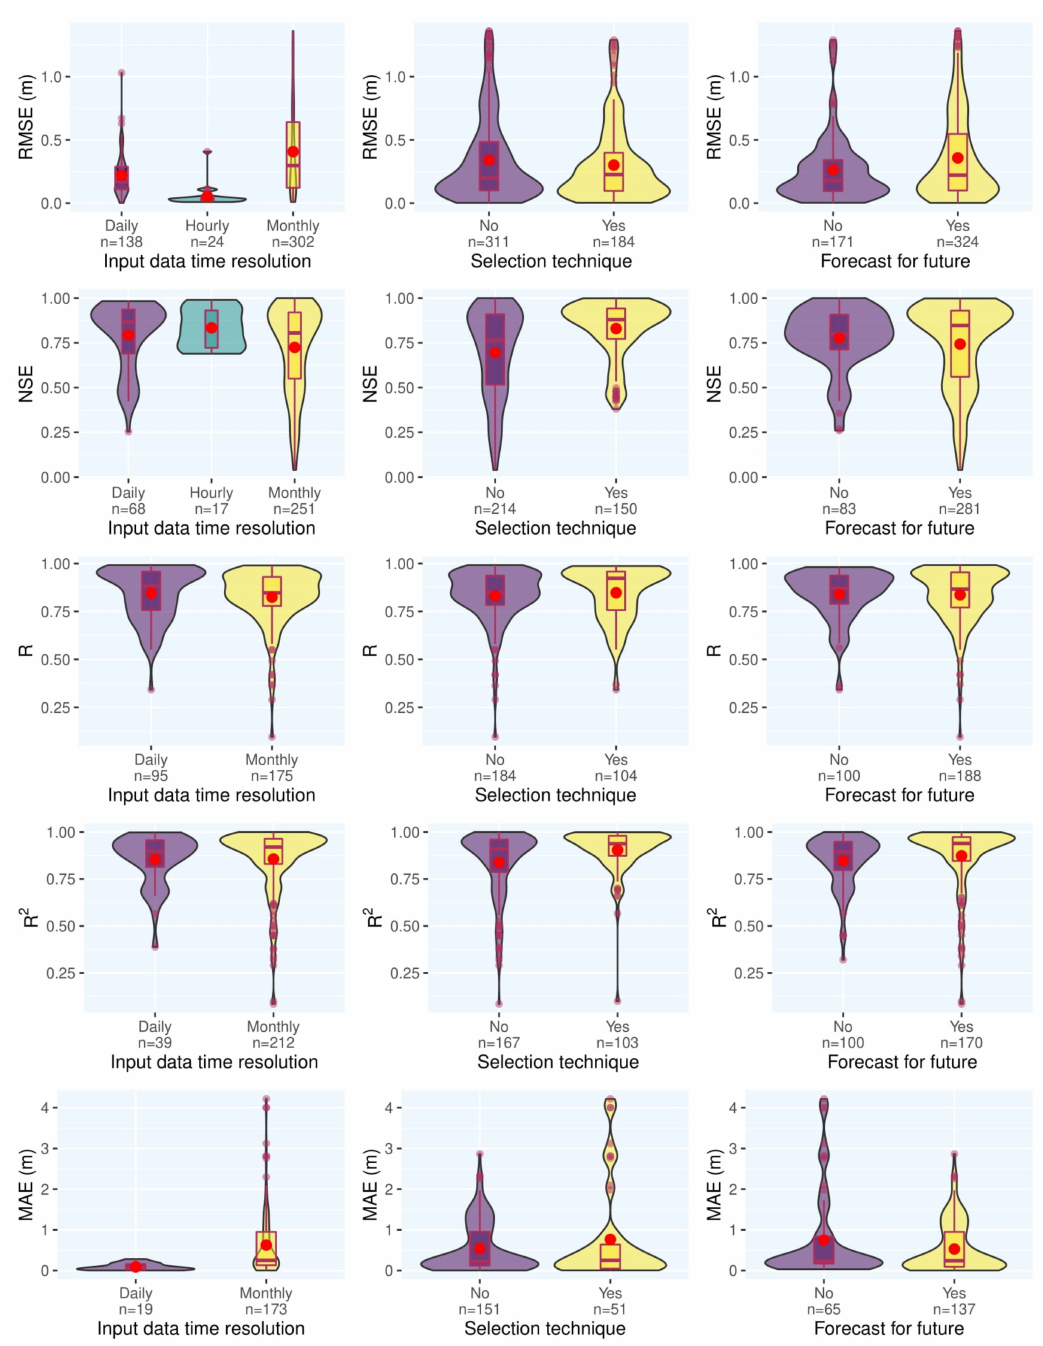
Figure 15. Meta-analysis results for three subcategories in the reviewed reports for groundwater level